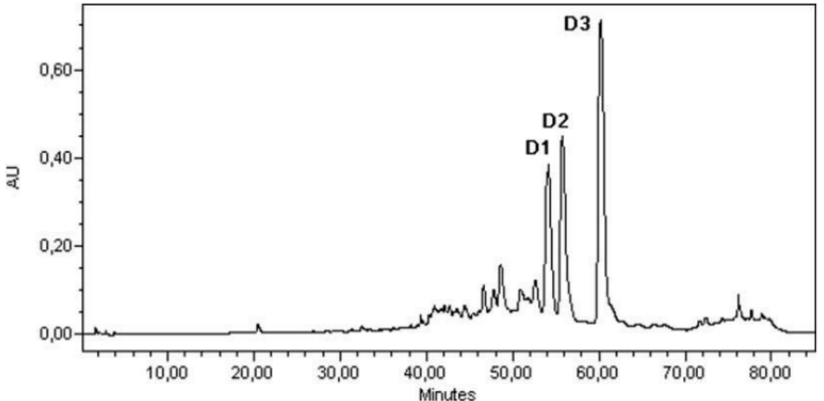
Figure 3. HPLC chromatogram of diterpenes extracts captured at 260 nm. D1: